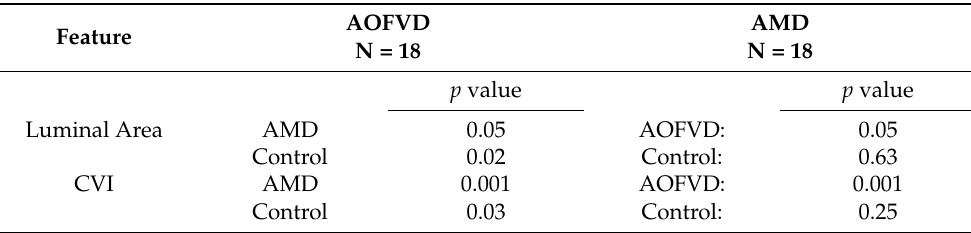
Table 3. Post- hoc analysis of the different subgroups; adult-onset foveomacular vitelliform dystrophy (AOFVD) and age-related macular degeneration with conventional